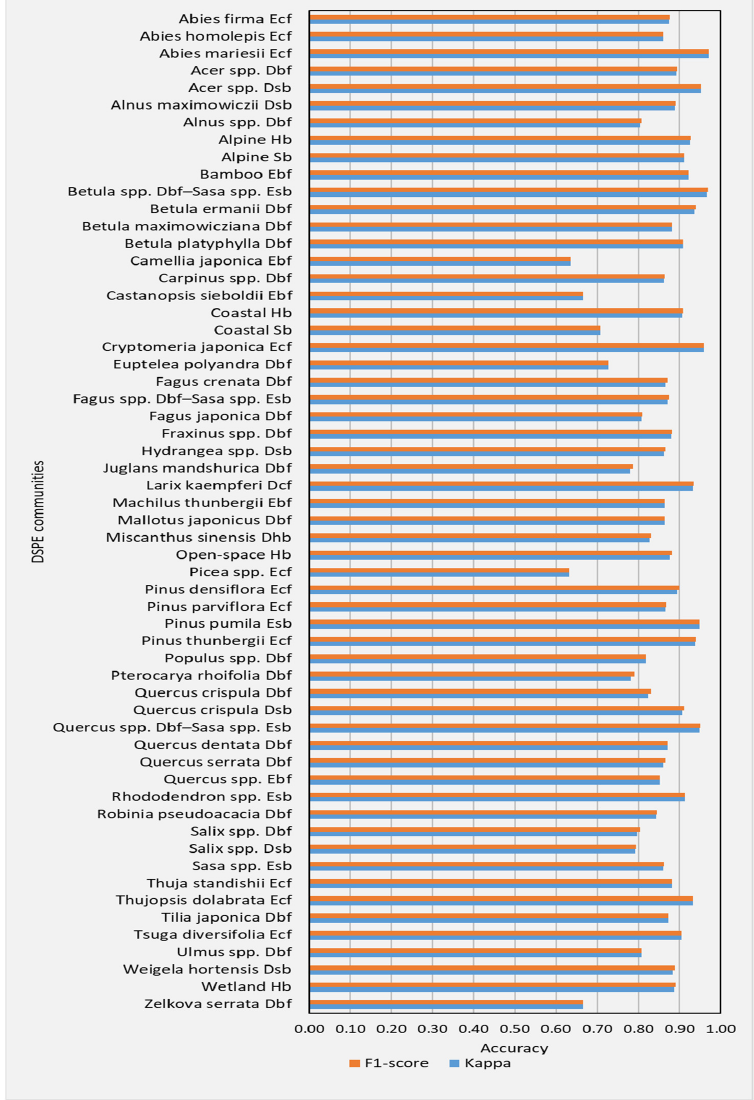
Figure 3. Class wise mean F1-score and Kappa coefficient values calculated for the classification of DSPE communities across 1000-run of bootstrap resampling.